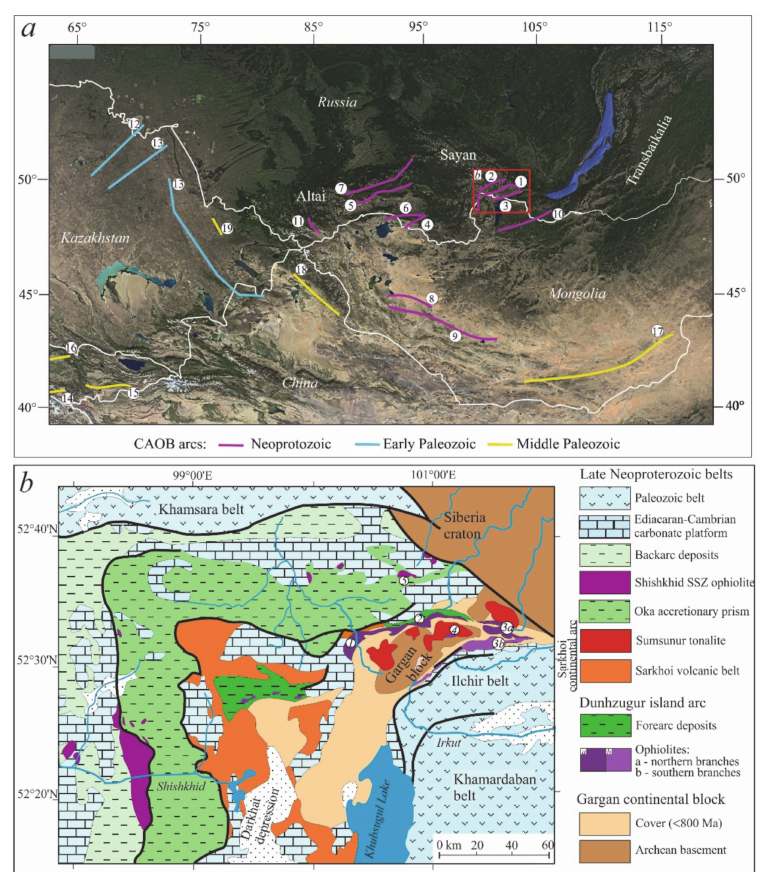
Figure 1. ( a ) Fossil island oceanic arc systems of the Central Asian Orogenic Belt (CAOB). Siberian Group: Neoproterozoic to early Cambrian island oceanic arcs of Siberia and Mongolia (pink). Kazakhstan Group: Early Paleozoic arcs of Kazakhstan (blue). Southern Group: Middle Paleozoic arcs of Tienshan, Chinese Altai, and Mongolia (yellow). Lines marking fossil intra-oceanic arcs made according to [5,10,33] (and references therein). The scheme was taken from [33].